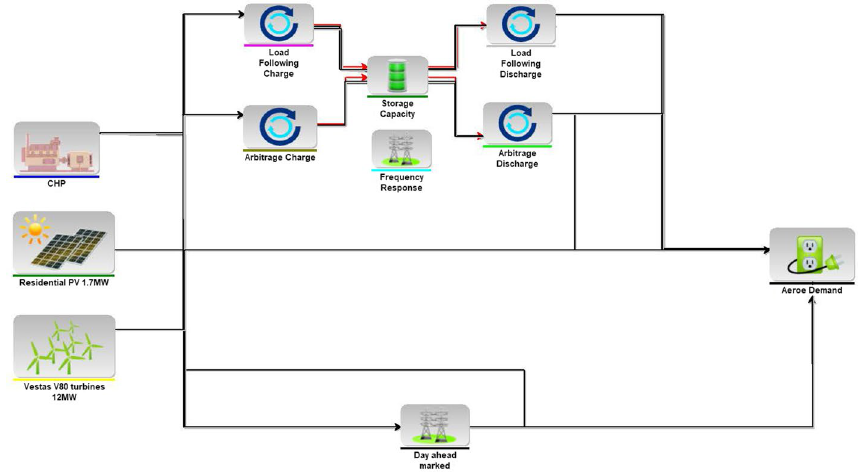
Fig. 6 Aeroe microgrid model in